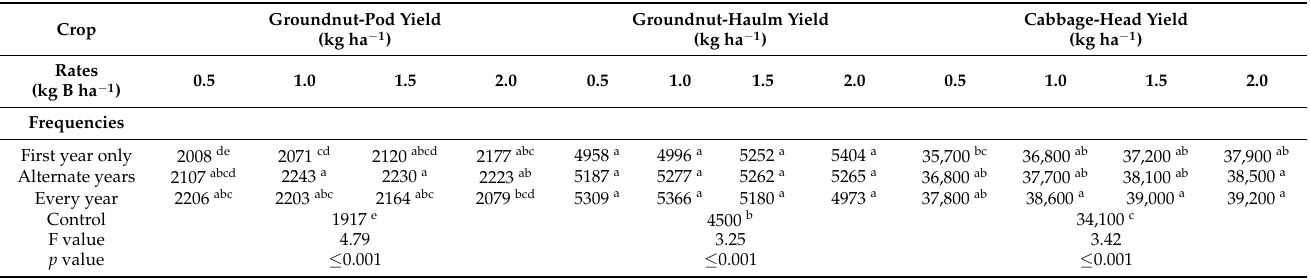
Table 1. Groundnut and cabbage yield under various dosages of B application to groundnut and cabbage cropping system.